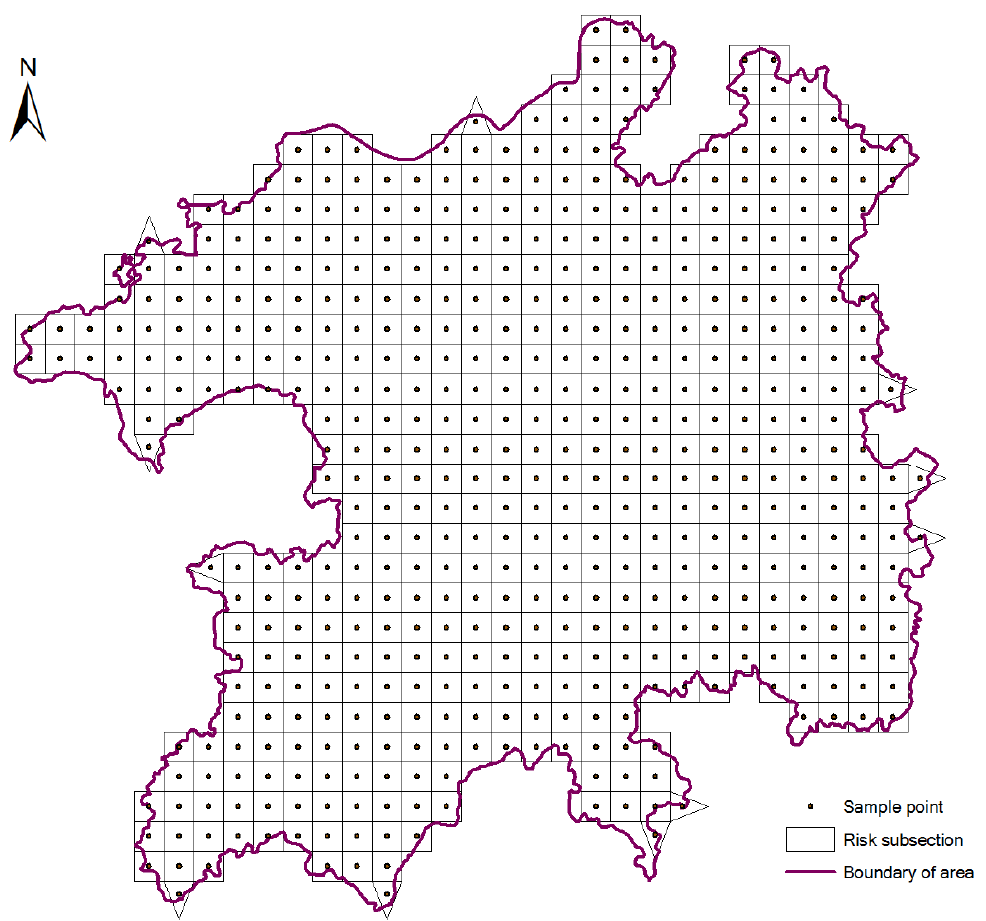
Figure 2. Division of the ecological risk